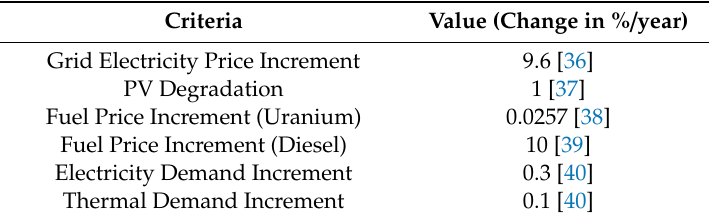
Table 7. Parameters of the multi-year